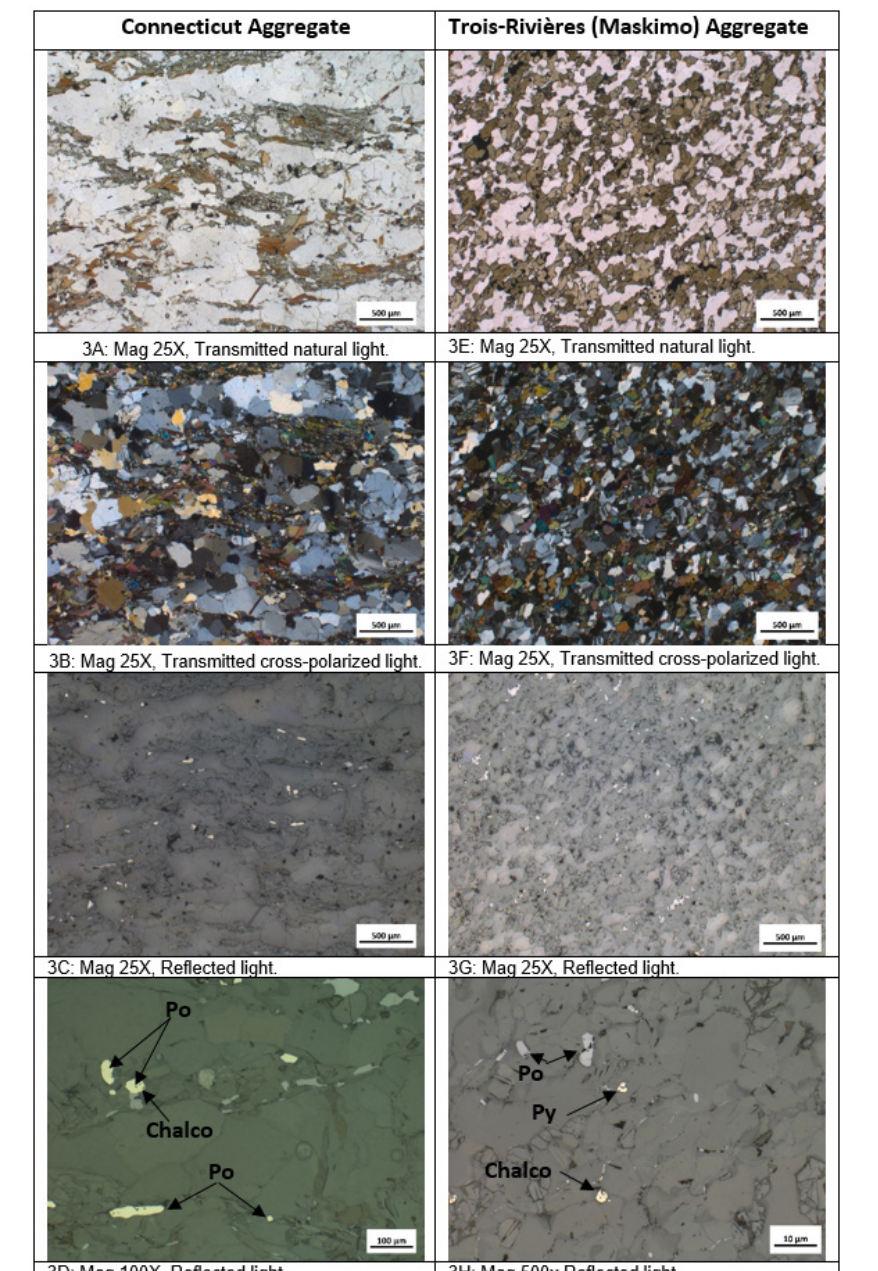
Figure 3. Microscopic images of aggregate samples with disseminated sulfides from Connecticut (left) and Trois-Rivières (right). Po: pyrrhotite; Py: pyrite; Chalco: